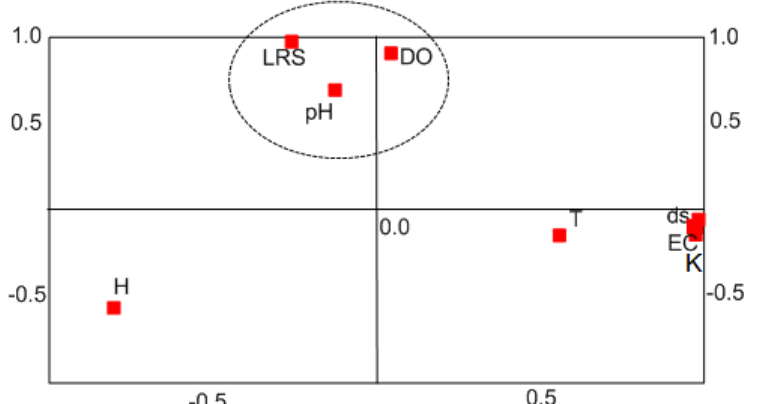
Figure 5. Visualization of factors EC – K and DO, and coefficients showing a high correlation between LRS, DO, and p H.